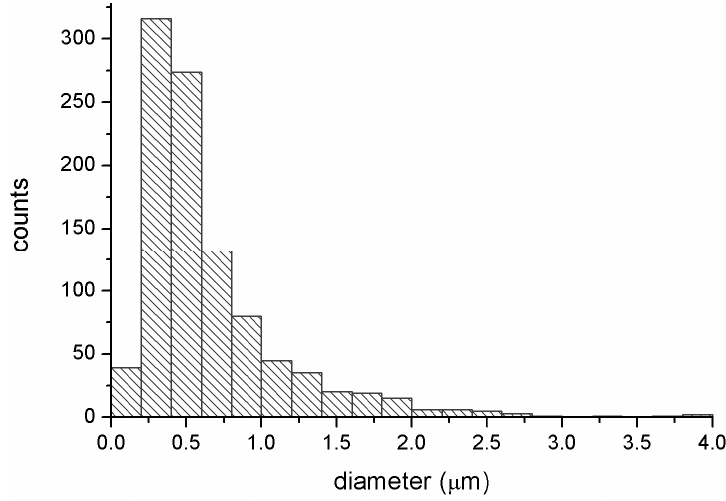
Figure 5. Particle size histogram of fibers in nonwoven WSB 1 .